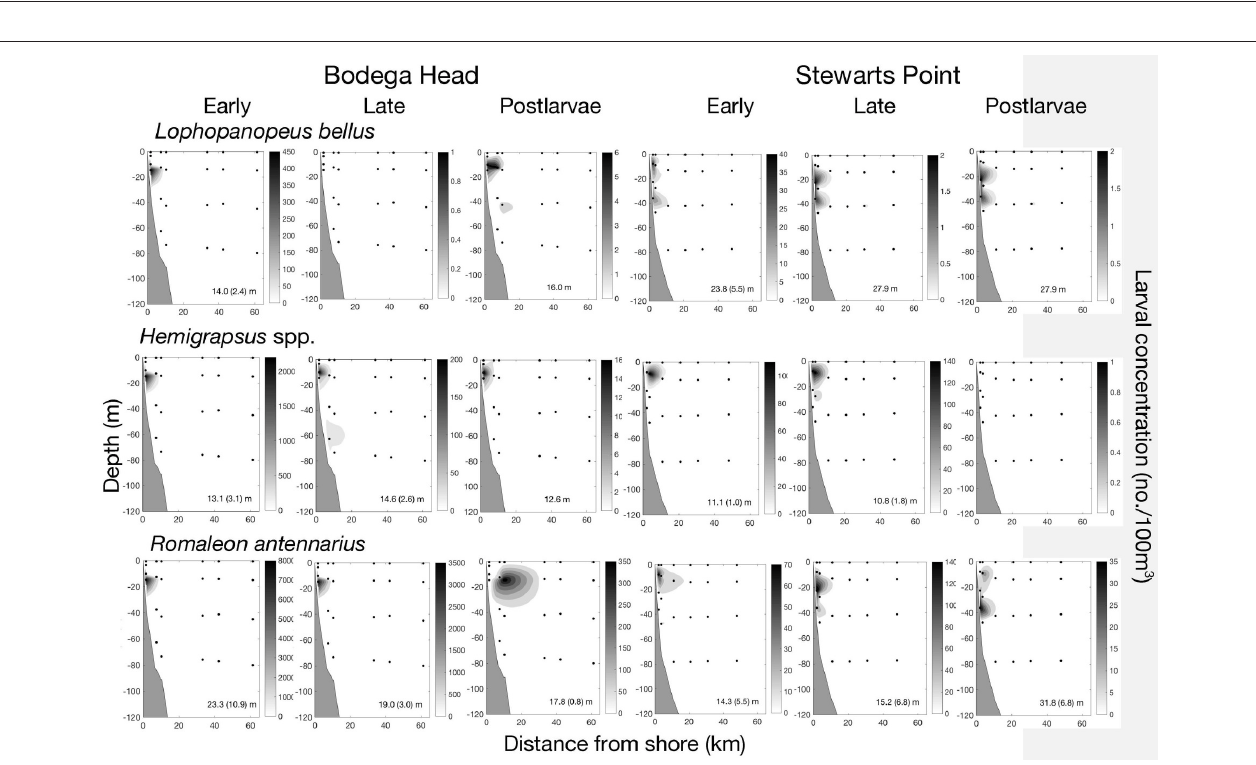
FIGURE 8 | pea crabs (Pinnixa faba, P. tubicola, Pinnotheres pugettensis, Scleroplax granulata, Fabia subquadrata , two unidentified species). The depth center of mass (ZCM; mean with SE in parentheses) is given at the bottom of each panel. ZCM with no variation shown in parentheses indicates species were collected during a single cruise, and separate groups of larvae within panels were collected during different cruises. Missing panel indicates that small larvae passed through nets.